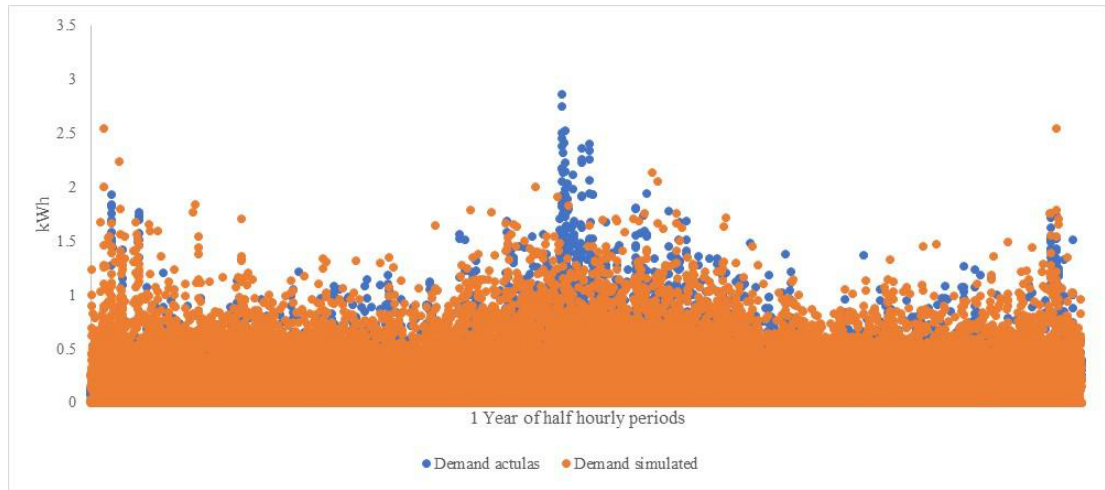
Figure 7. Simulated and historical household energy demand, 1 yr half-hourly.